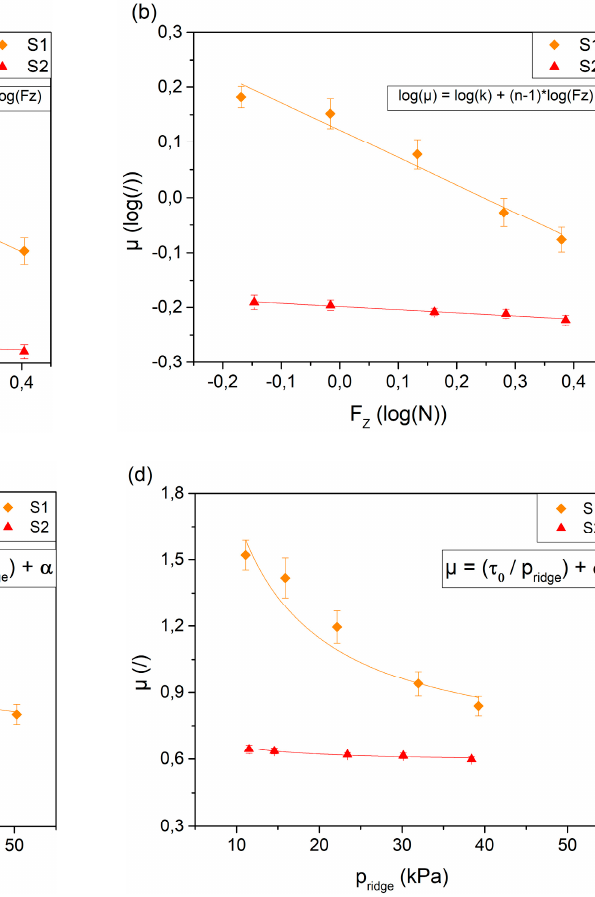
Figure 7. The diagrams ( a ) and ( b ) show a logarithmic representation of the average coefficient of friction vs. the normal load for the two surfaces for the ( a ) forward and ( b ) backward movement and the corresponding linear fits. ( c , d ) The coefficient of friction vs. the contact pressure for the ( c ) forward and ( d ) backward motion and the corresponding curve fits.